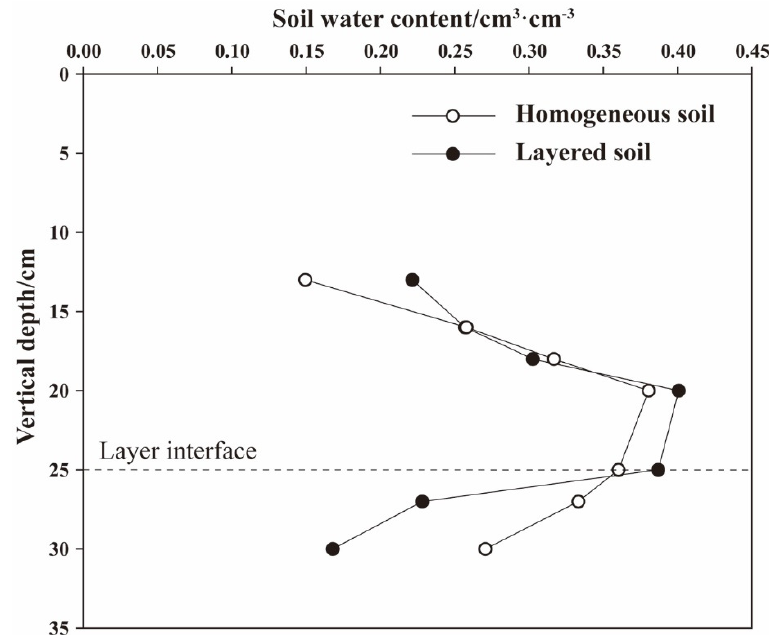
Figure 11. Soil moisture content by depth.